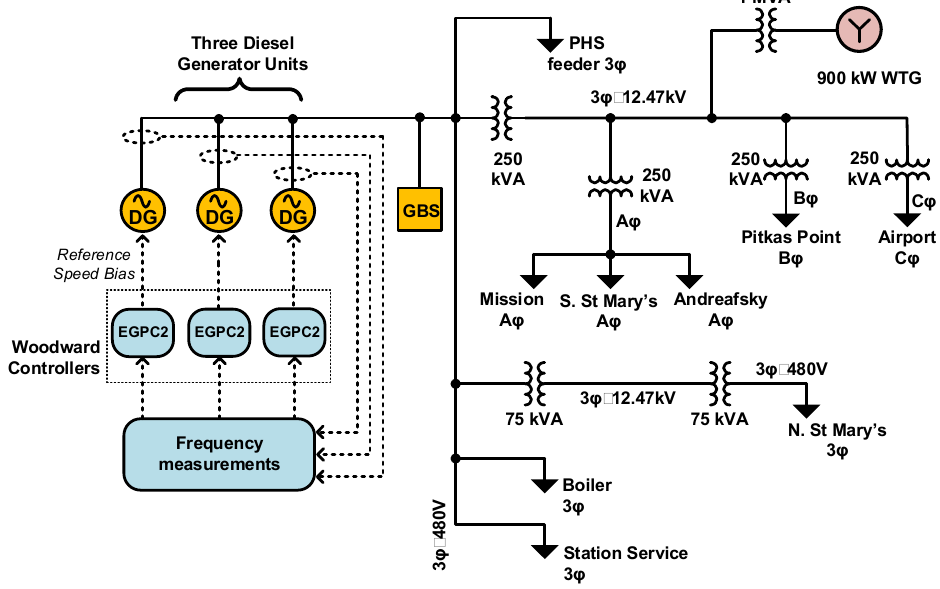
Figure 1. Schematic of the Electrical Power System of St. Mary’s.